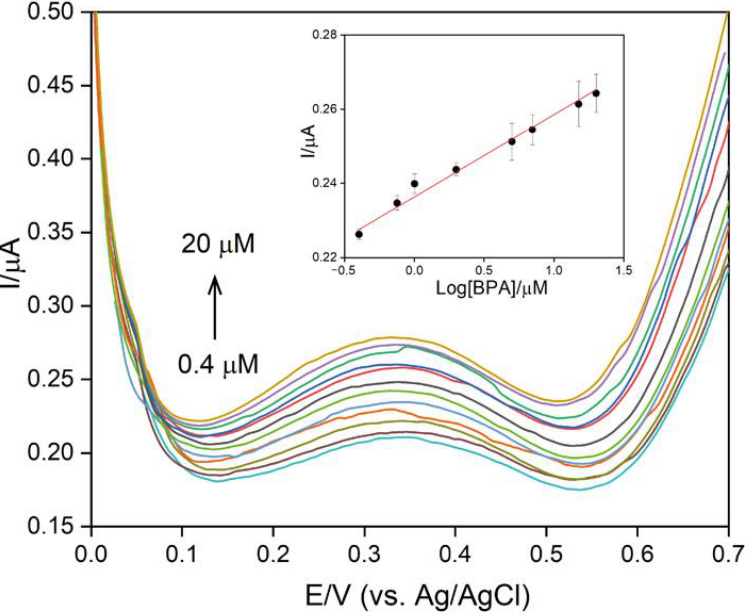
Figure 3. DPV curves at different concentrations of BPA for FTO-(Chi/CNTs) 3 in 0.01 mol L − 1 PBS (pH 7.4). The inset shows the linear relationship between the peak current ( I p ) and log of BPA con- centrations.